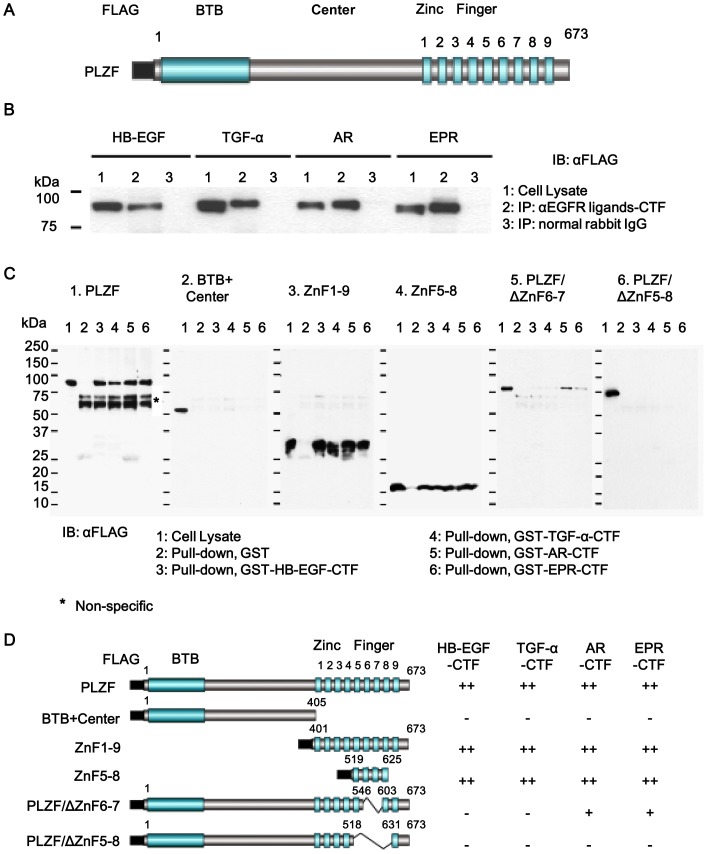
Binding of EGFR ligand-CTFs to ZnF5-8 region of PLZF.(A) Schema of FLAG-tagged full length PLZF consisting of FLAG, BTB, Center, and nine ZnFs. (B) HT1080 cells stably expressing pro-HB-EGF, pro-TGF-α, pro-AR and pro-EPR were transiently transfected with an expression vector encoding FLAG-tagged PLZF. PLZF protein expression of cell lysates (lane1), as well as, cells treated with 100 nM TPA for 1 h, and probed with anti-FLAG antibodies following immunoprecipitation with anti-EGFR ligands-CTF antibodies (lane2) and an anti-normal rabbit IgG (lane3). (C) GST pull-down assay. Cell lysates containing FLAG-tagged PLZF derivatives were incubated with GST (lane 2), GST-HB-EGF-CTF (lane 3), GST-TGF-α-CTF (lane4), GST-AR-CTF (lane 5), and GST-EPR-CTF (lane 6) beads for 2 h, and bound proteins were detected by immunoblotting with an anti-FLAG antibody. (D) Schema of FLAG-tagged PLZF derivatives. The binding properties of PLZF derivatives to GST-fused- HB-EGF-CTF, TGF-α-CTF, AR-CTF and EPR-CTF GST in a pull-down assay, as summarized in the right lanes of each structure. Binding properties are based on the estimation of band intensity with are relative to the control band and indicated by++(>50%),+(50–10%), and − (<10%).